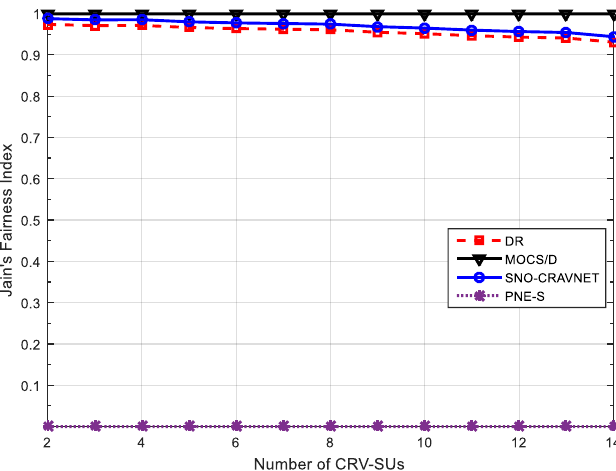
Figure 7. Resource allocation fairness performance evaluation using Jain’s fairness index (JFI) measured against a varying number of CRV-SUs.